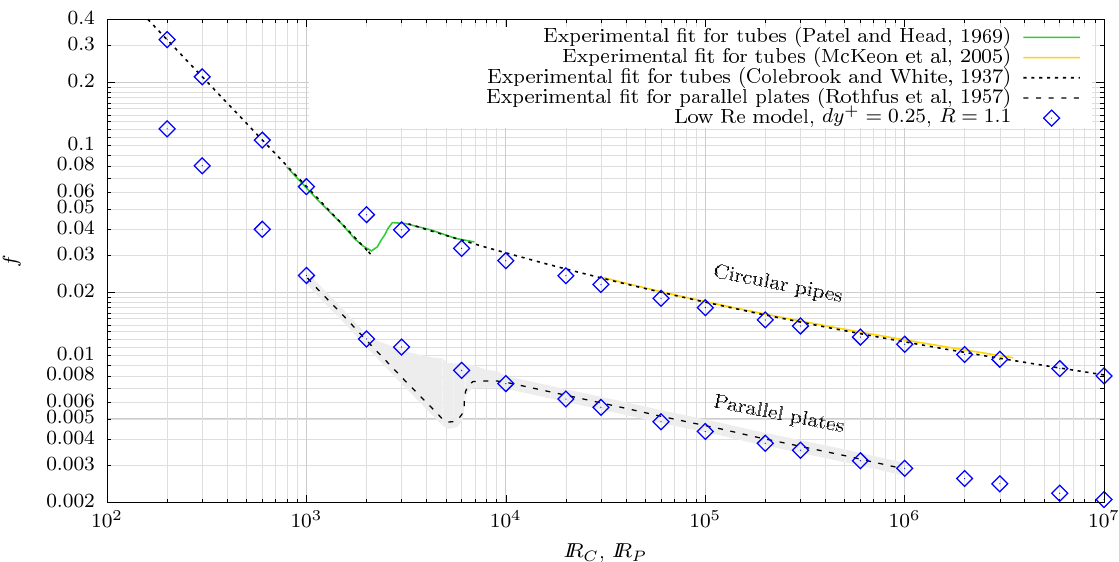
Figure 4: Comparison between friction factor from LRN treatment and from experimental results.